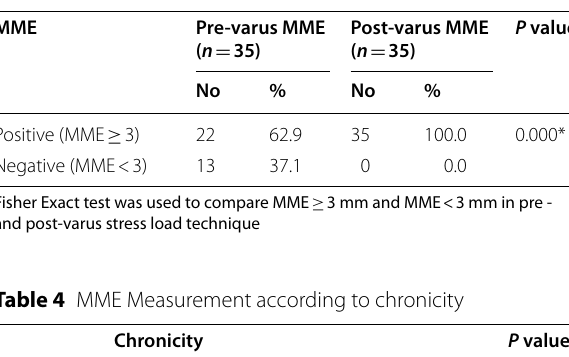
Table 3 Comparison of pre and post‑varus MME in 35 patients